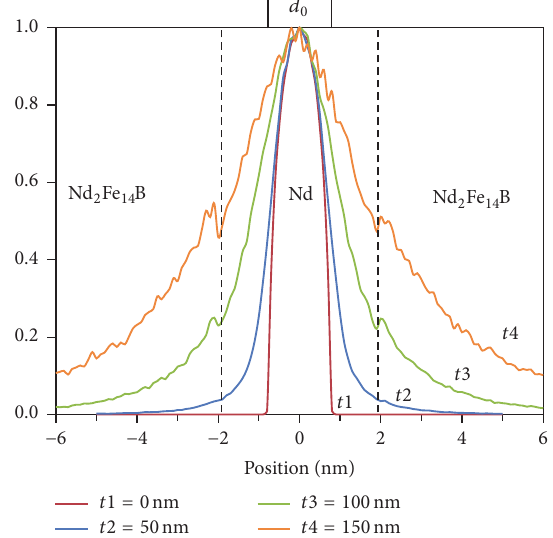
Figure 2: Electron density of the electron beam at the bottom sur- face of the TEM specimen, showing the electron beam broadening of a 1.5 nm ( 𝑑 0 , red curve) wide beam with a semiconvergence angle of 6 mrad, which is focused on the surface of the 4 nm thick neodymium GB, which is surrounded by two Nd 2 Fe 14 B grains in the TEM specimen with varying thickness. Significant broadening of the incident electron beam occurs at a sample thickness > 50